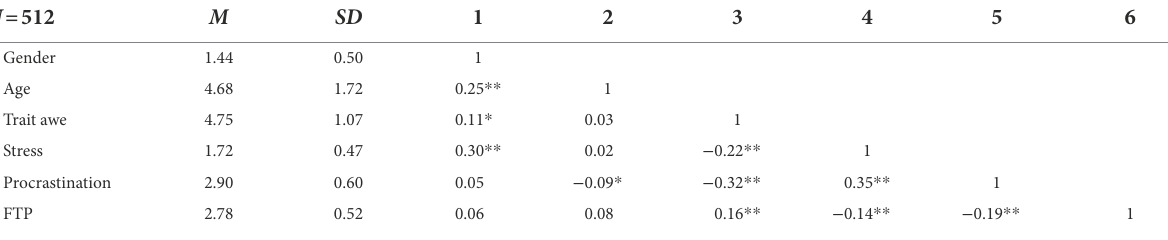
TABLE 1 Mean values, standard deviations, and correlations for the key variables. N =